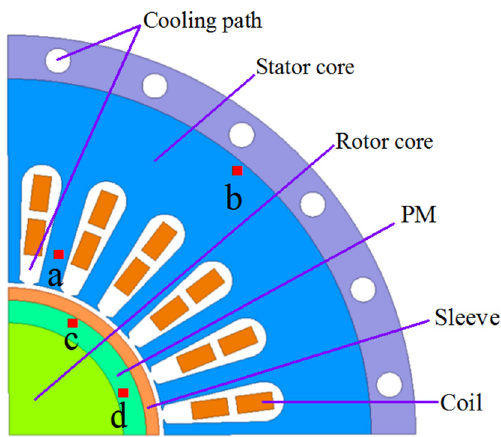
Figure 6. Structure of HSPMM.